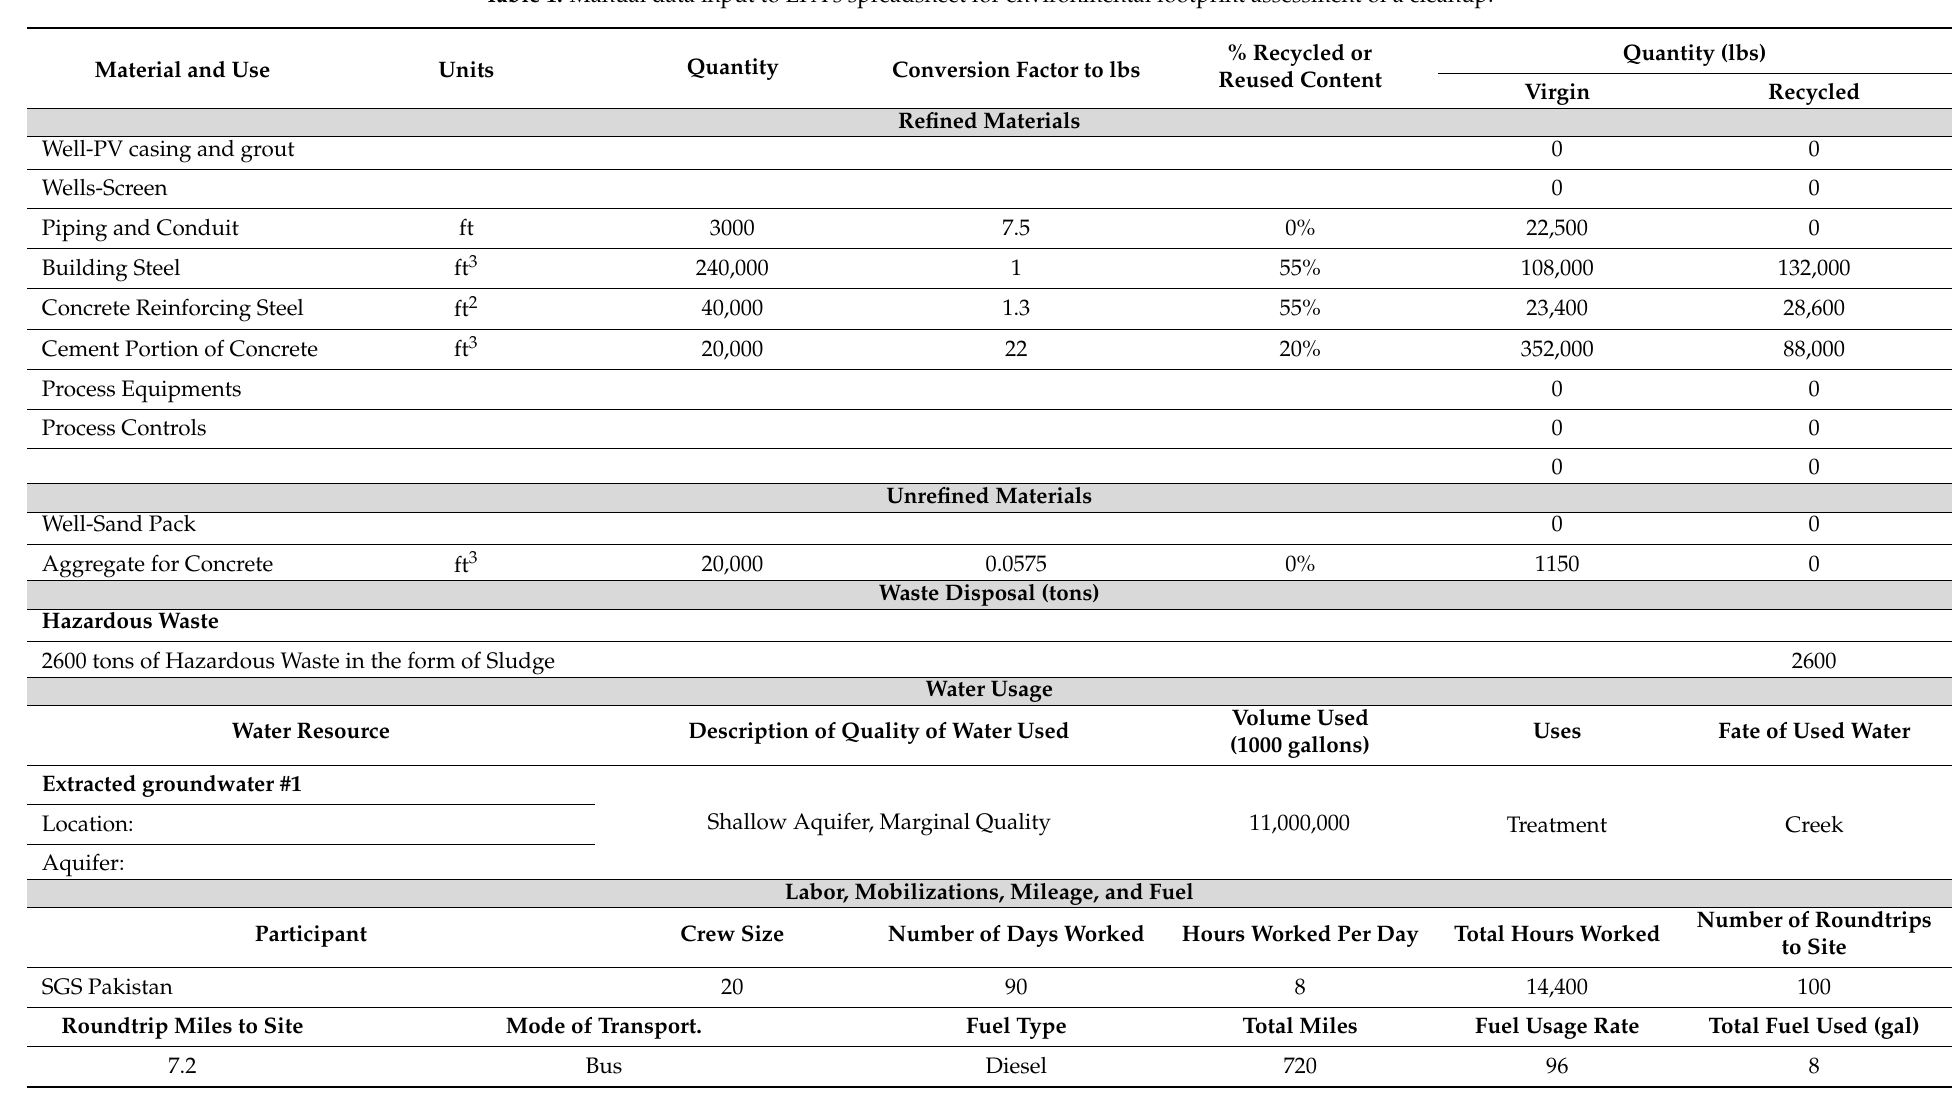
Table 1. Manual data input to EPA’s spreadsheet for environmental footprint assessment of a